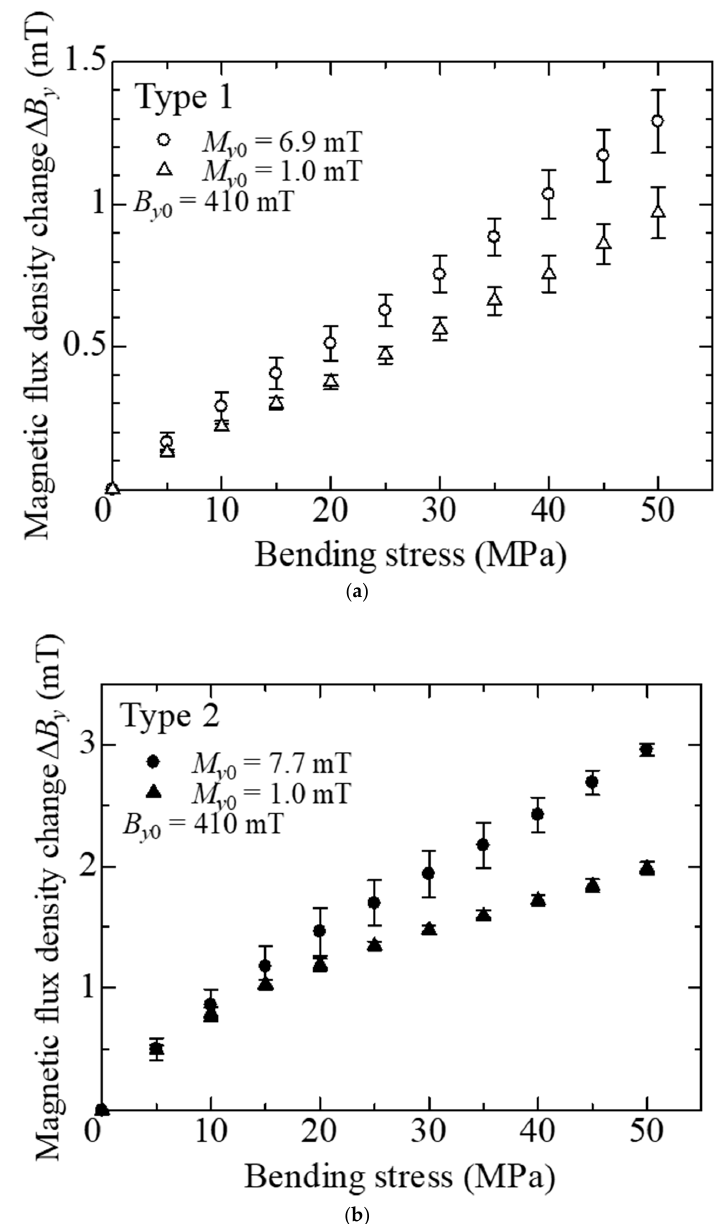
Figure 8. Magnetic flux density change ∆ B y versus bending stress of the ( a ) Type 1 and ( b ) Type 2 samples.